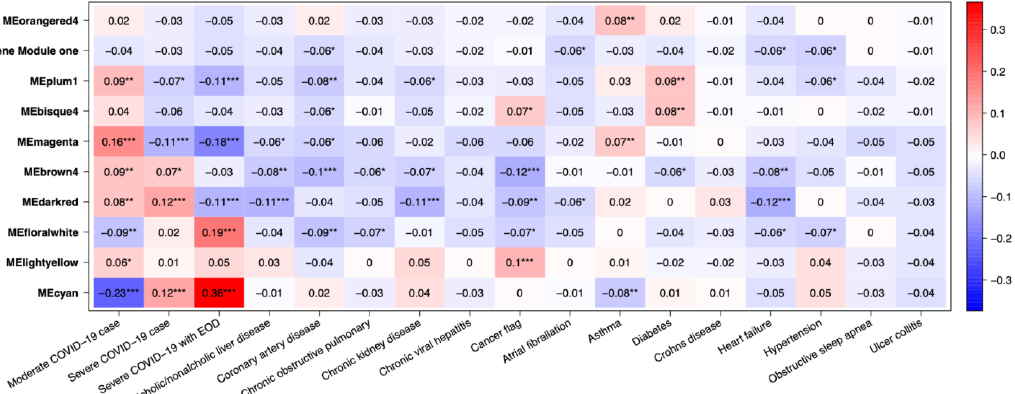
Figure 11. Heatmaps of module traits for severity and disease comorbidity. The boxes indicate the correlation based on module eigengenes in the rows and traits in the column. The color legend—blue (negative correlation) and red (positive correlation). p -values represented by asterisks indicated significance. Asterix signs indicate the order of significance where ***—very significant, **—significant, and *—significant.